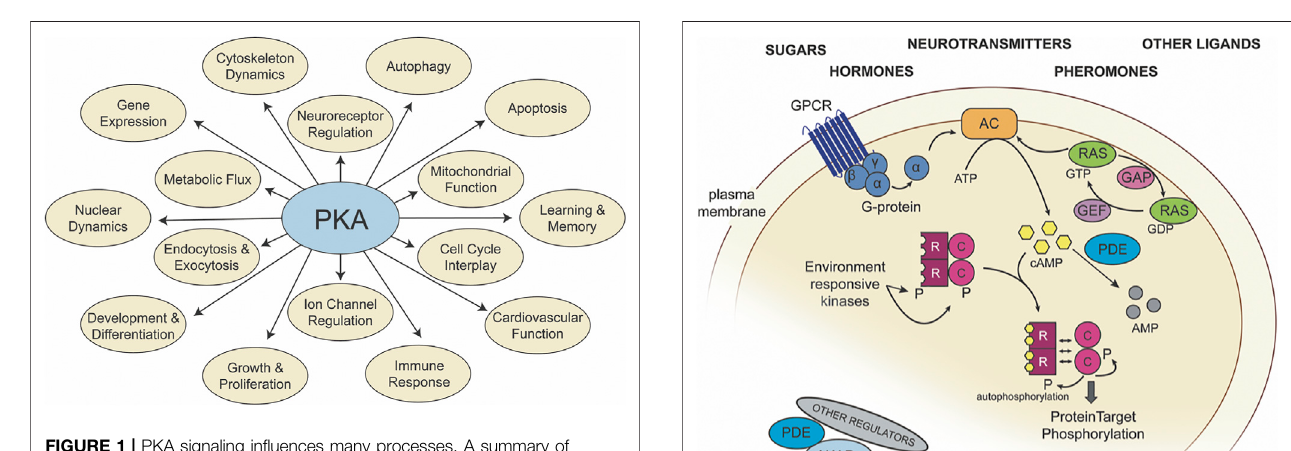
FIGURE 1 | PKA signaling in fl uences many processes. A summary of processes in fl uenced by PKA signaling, through direct phosphorylation of participating proteins.